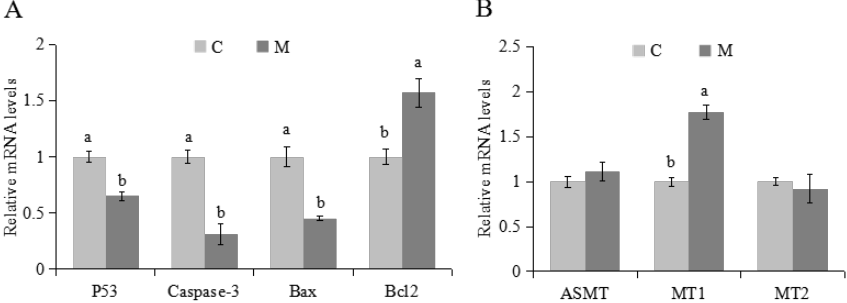
Figure 4. Effects of melatonin on expression of related genes in cumulus cells. Expression of related apoptosis genes in cumulus cells ( A ); expression of melatonin synthetase and receptors genes ( B ). The experiment was repeated three times; data presented as mean ± SEM; a,b for adjacent columns, means without a common superscript differed ( p < 0.05).